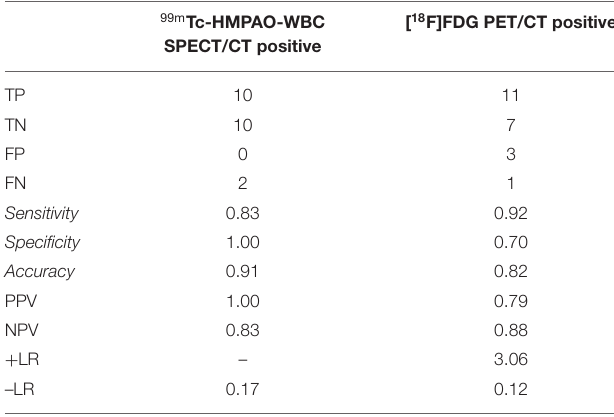
TABLE 6 | Diagnostic performance of 99m Tc-HMPAO-WBC SPECT/CT and [ 18 F]FDG PET/CT in 22 patients with early/very early